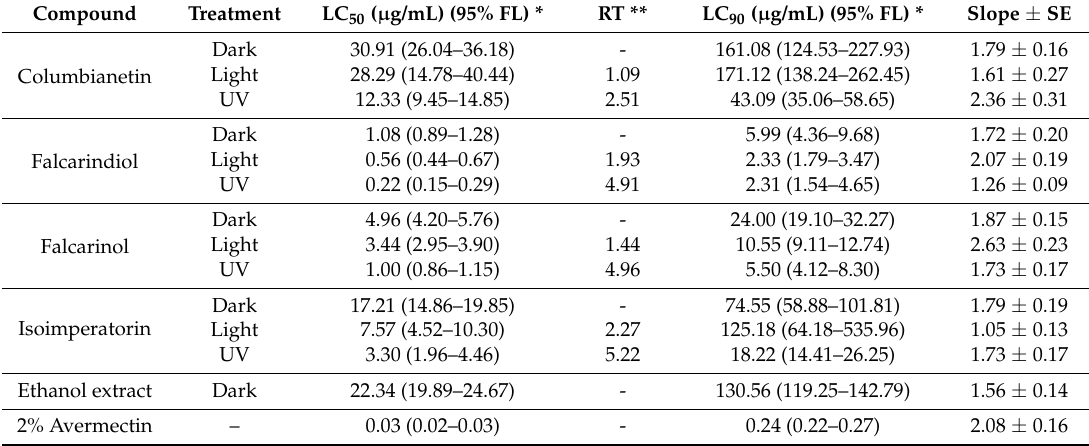
Table 2. Nematicidal activity of bioactive compounds from Notopterygium incisum rhizomes against Meloidogyne incognita